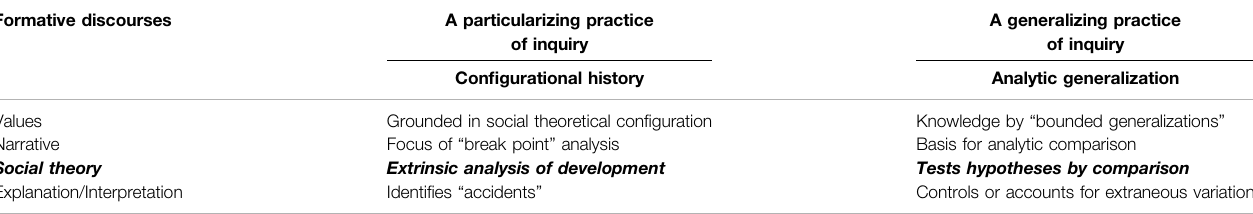
TABLE1| Theroleofformativediscoursesininquirypracticesofcon fi gurationalhistoryandanalyticgeneralization,withtheircommonorderingdiscourseanditsrolesinitalic bold [based off Hall (1999), Tables 7.1 and 8.1]. Formative